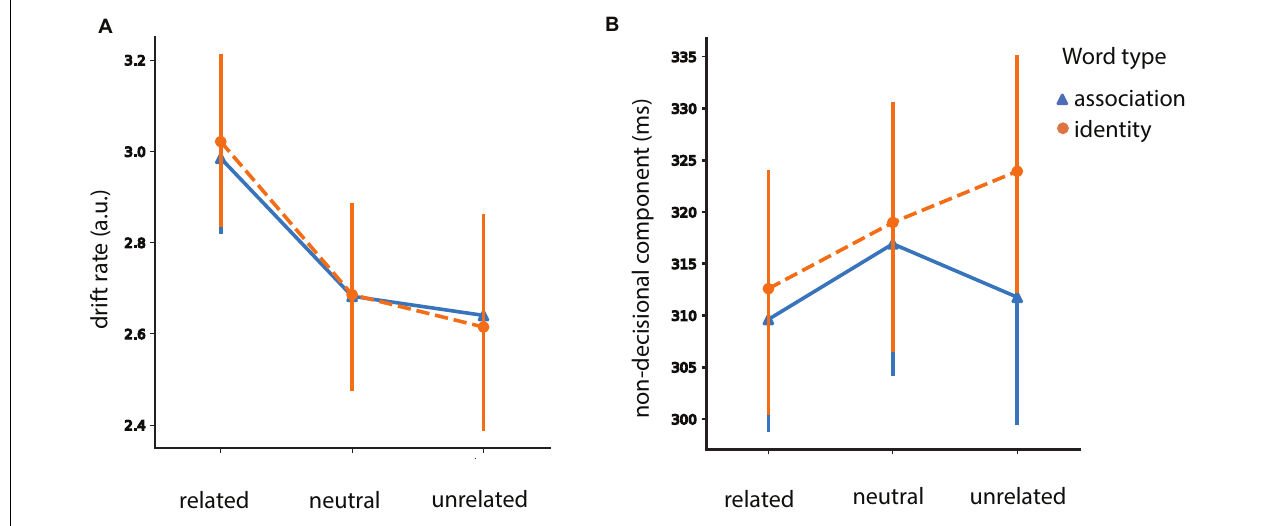
FIGURE 8 | Congruency analysis. Posterior estimates of the hierarchical drift-diffusion model for the drift rate ( v ) and non-decisional parameter ( T er ). Error bars represent 95% confidence interval